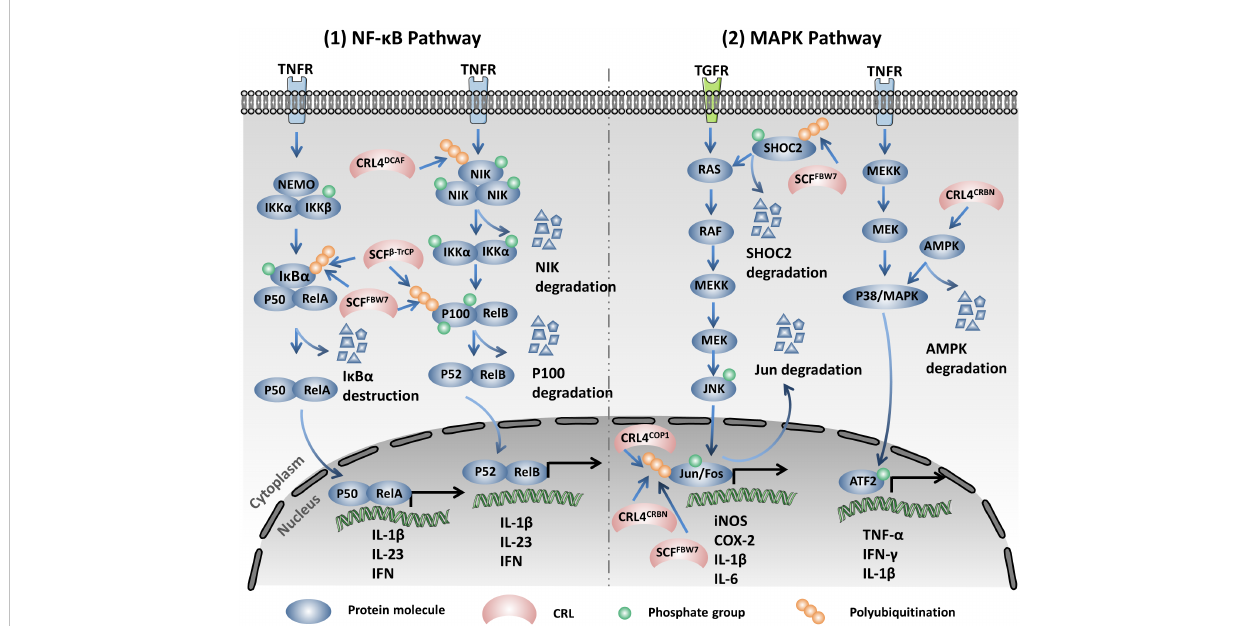
FIGURE 1 Cullin-RING ligases (CRLs) regulate the expression of multiple pro-in fl ammatory cytokines through modulating the nuclear factor kappa B (NF- k B) and mitogen-activated protein kinase (MAPK) signaling pathways. Left : SCF b -TrCP mediates the degradation of the NF- k B inhibitor I k B after phosphorylation by I k B kinase (IKK). CRL4 DCAF2 mediates the poly-ubiquitination and destruction of the NF- k B-inducing kinase (NIK). SCF b -TrCP modi fi es p100 at the C-terminal domain and induces degradation, generating the p52 mature subunit. SCF FBW7 recognizes and destroys the I k B and p100 in the ubiquitination proteasome system (UPS). These CRLs modulate the NF- k B pathway through regulating the stability of the key components. Right : SCFFBW7 mediates the ubiquitination and proteolysis of SHOC2 after being phosphorylated by MAPK at Thr507 and blocks the RAS-MAPK pathway. CRL4 CRBN promotes the K48 linkage ubiquitination and the subsequent degradation of c-Jun and restrains the activity of the AP-1 complex. COP1, another Cul4-based E3 ubiquitin ligase, also regulates the protein stability of c-Jun. SCF FBW7 mediates the ubiquitination and destruction of c-Jun by proteasome. CRL4 CRBN promotes a non-K48 linkage ubiquitination and the degradation of